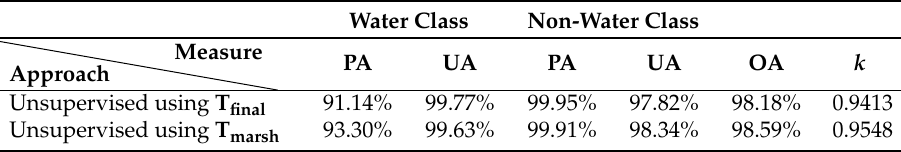
Table 9. Combined accuracy assessment for the marshland and 7 different